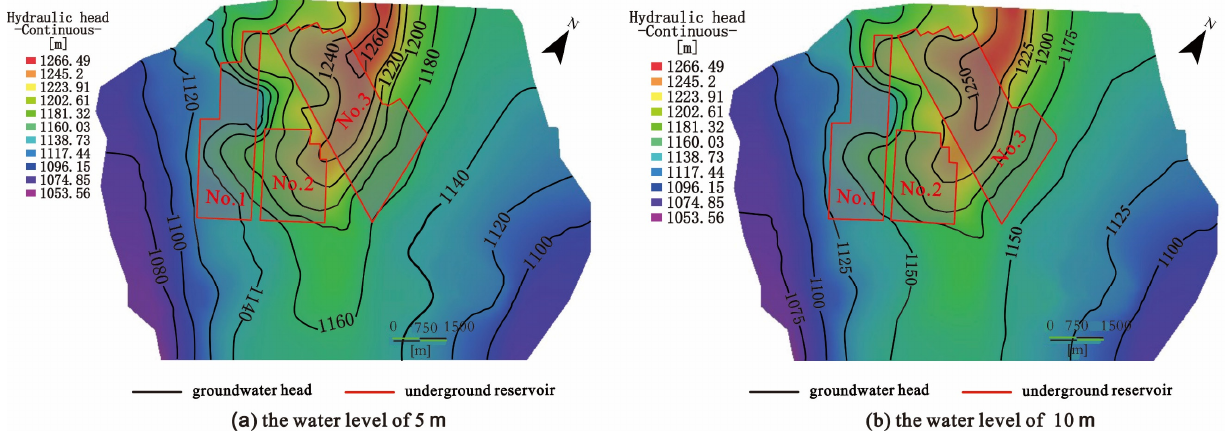
Figure 17. Groundwater contour map of the upper aquifer system for different impoundment heights of the underground reservoir: ( a ) 5 m, ( b ) 10 m.